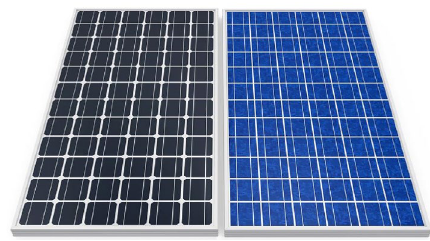
Fig. 5 Polycrystalline solar panel and its specification